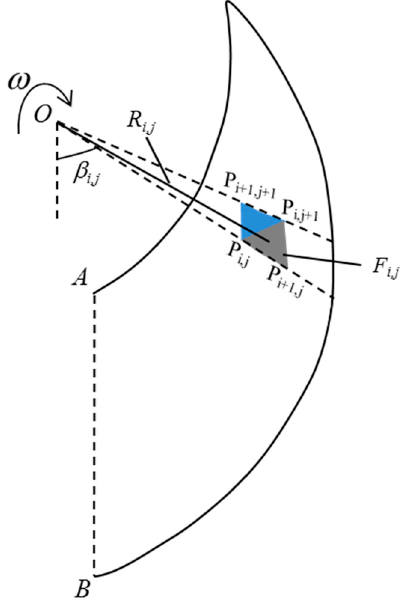
Figure 5. Scheme of the calculation of the internal energy dissipation rate.